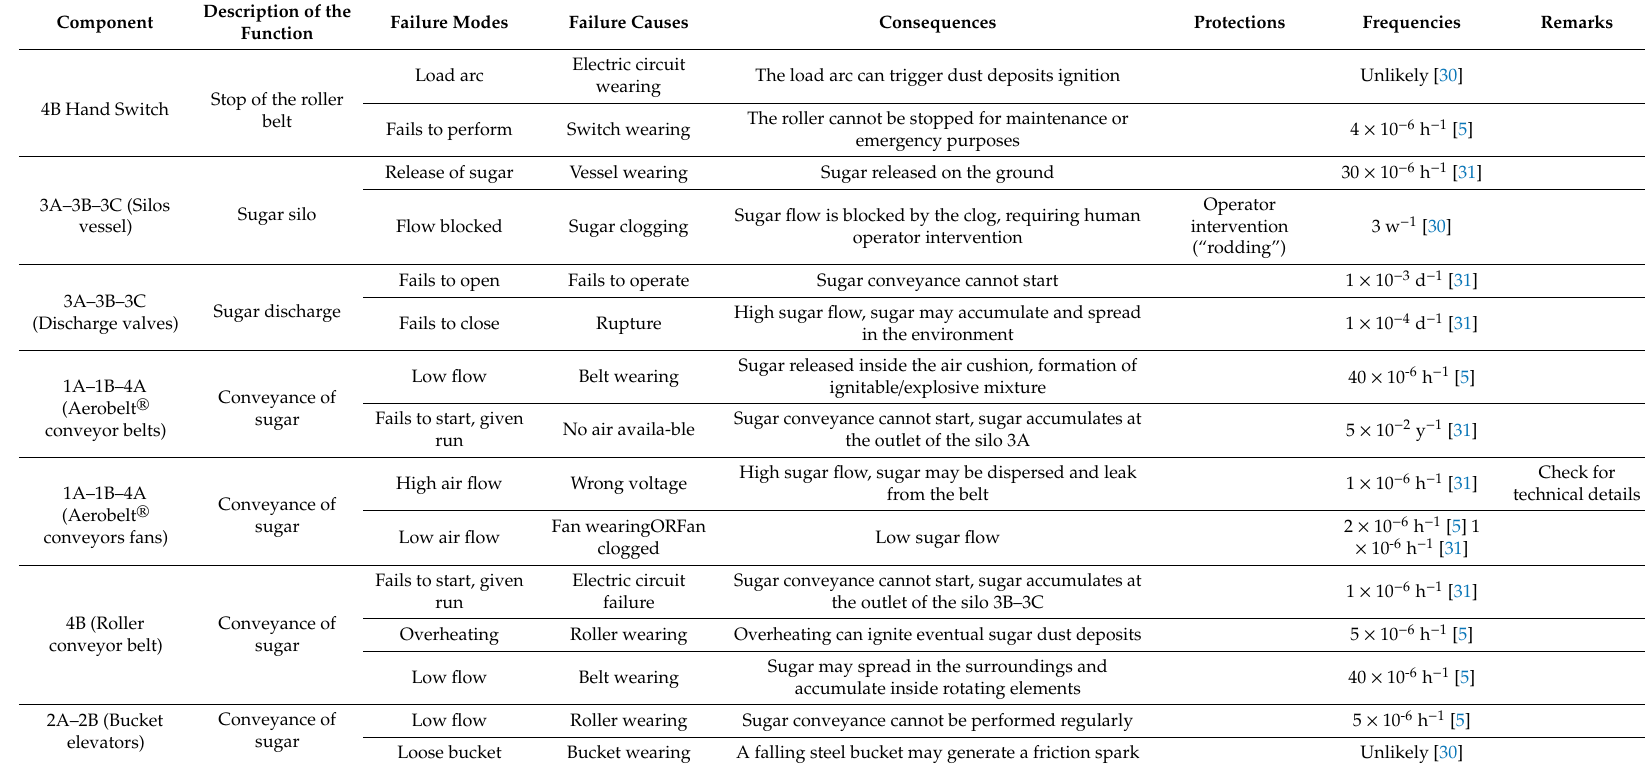
Table 5. FMEA per the involved components and human errors. Frequencies are represented as failure rates. (h—hour; d—day; w—week; y—year)